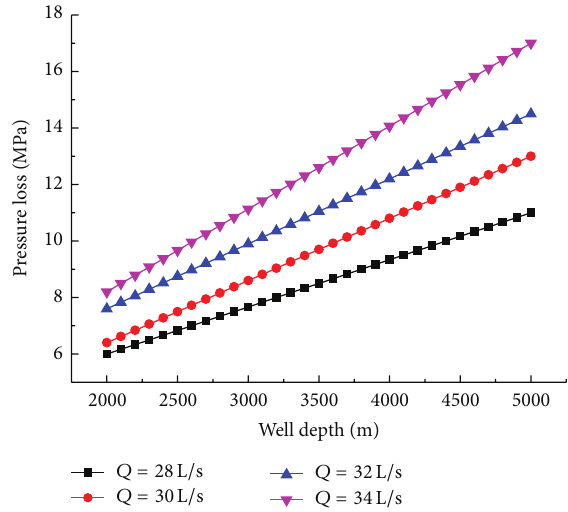
Figure 1: Impact of well depth on pipe pressure